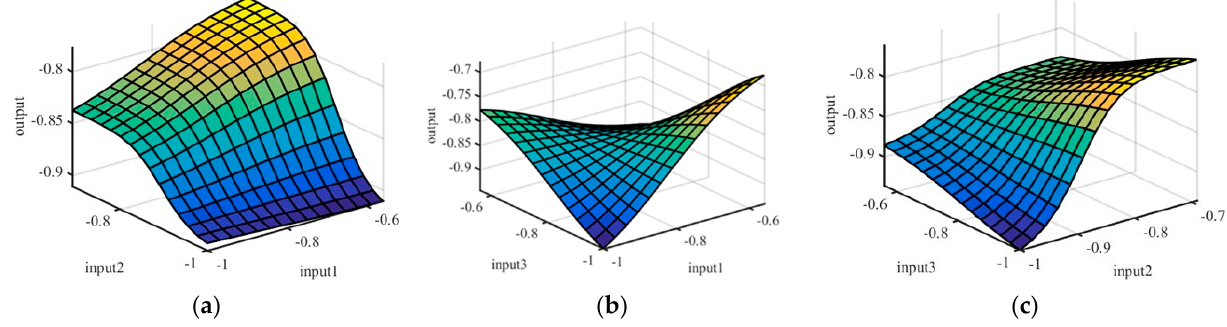
Figure 10. Combined effects of ( a ) R ( t ) and R ( t -1), ( b ) R ( t ) and R ( t -2), and ( c ) R ( t -1) and R ( t -2) on the output.